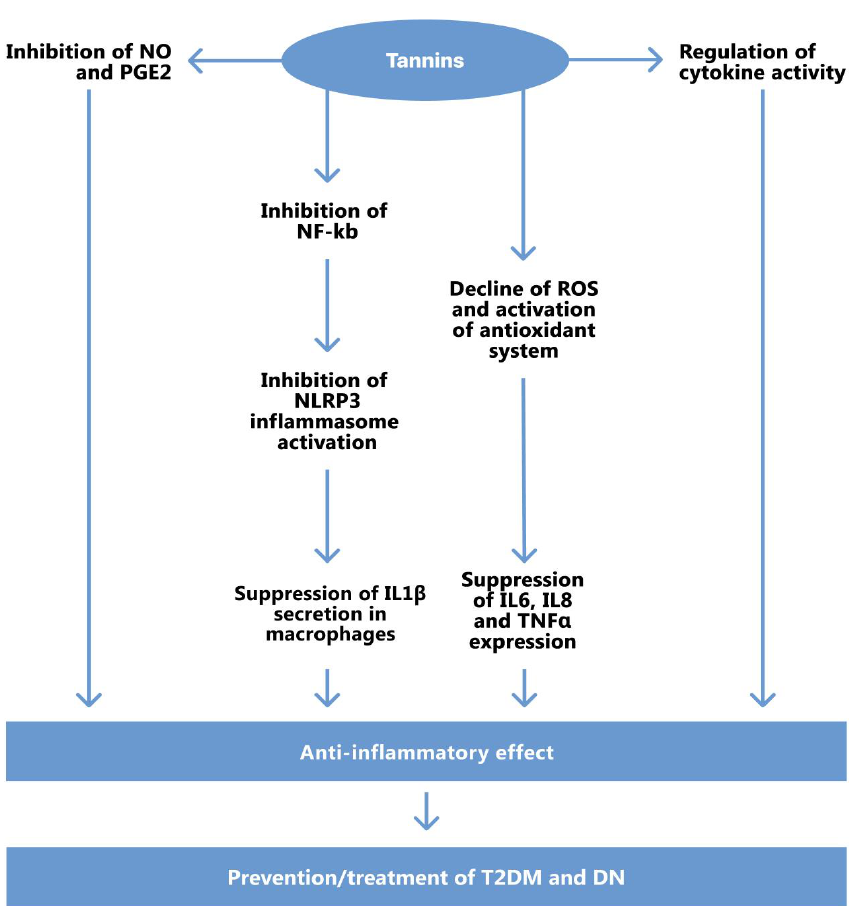
Figure 3. Possible pathways of the anti-inflammatory effect of tannins.